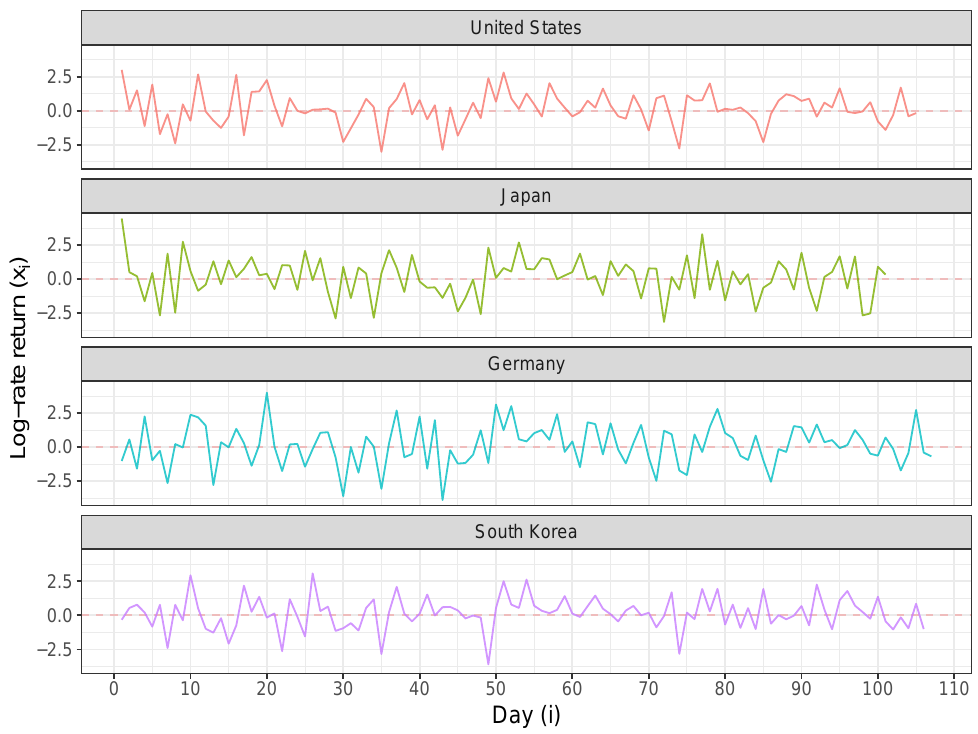
Figure 7. Daily returns of the index values from four countries for the period spanning 6 May 2009 to 30 September 2009.